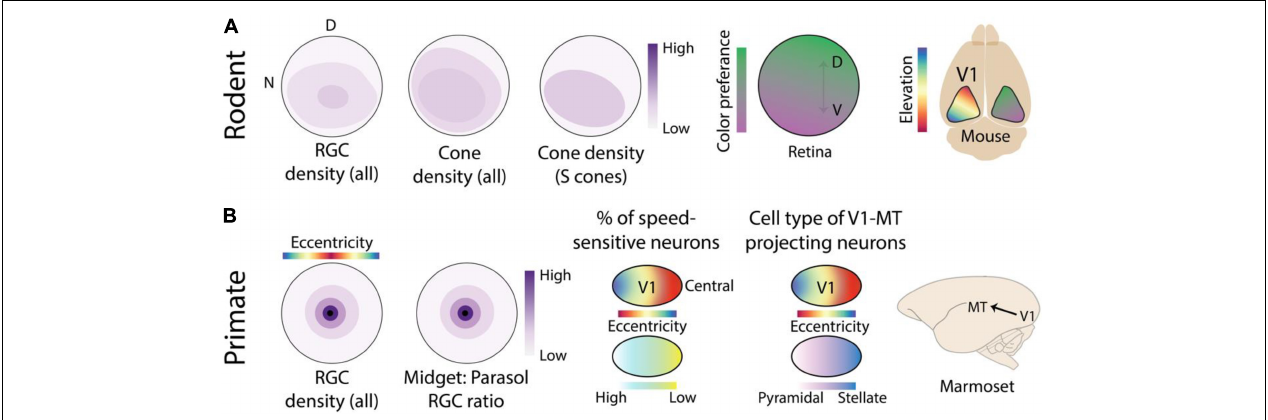
FIGURE 2 | Location-dependent feature sensitivity in the retina and early visual cortex of rodents and primates. (A) Averaged across all RGC cell types, the rodent retina has a slightly higher density in the ventral retina that receives input from the upper visual field, however this specialization is relatively much shallower than the foveal specialization of primates shown in panel (B) . In addition, the distribution of cone photoreceptors shows slight topographic anisotropies. However, when considering the distribution of short-wavelength (s) opsins alone, a much deeper gradient can be seen across the dorsal-ventral elevation axis (Nadal-Nicolás et al., 2020). This produces a location-dependent encoding of spectral sensitivity in the output pathways of the retina that is inherited by neurons in mouse V1 (Rhim et al., 2017). (B) Primate retinas exhibit foveal specialization, characterized by a sharp drop-off in RGC density with increasing distance from the center of the retina or equivalently, with increasing eccentricity. The ratio of midget and parasol RGC cell types also differs greatly with eccentricity, producing distinct functional response properties across the retina (Dacey, 1993). In marmoset V1, several subtle eccentricity-based specializations have been reported including a peripheral specialization for motion processing (Yu and Rosa, 2014; Yu et al., 2015). More notably, MT projecting neurons in layer 3C exhibit distinct cell types as a function of eccentricity (Mundinano et al., 2019). Retina figures are schematics designed to show topographic gradients, therefore the color bar is normalized and only indicates relative “high” and “low” ends of the